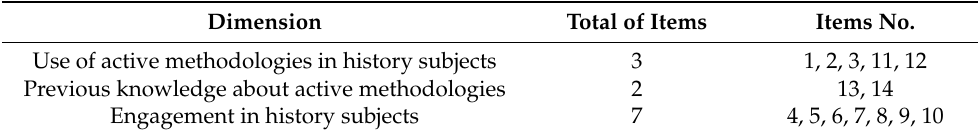
Table 2. Pre-questionnaire items. Dimension Total of Items Items No. Use of active methodologies in history subjects 3 1, 2, 3, 11, 12 Previous knowledge about active methodologies 2 Engagement in history